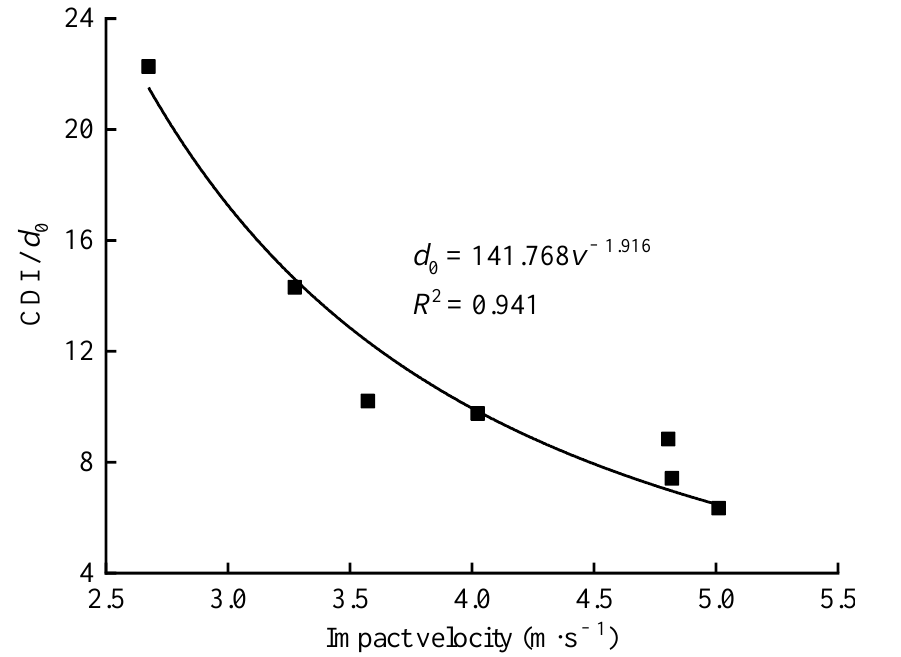
Figure 9. Relationship of CDI and impact velocity.